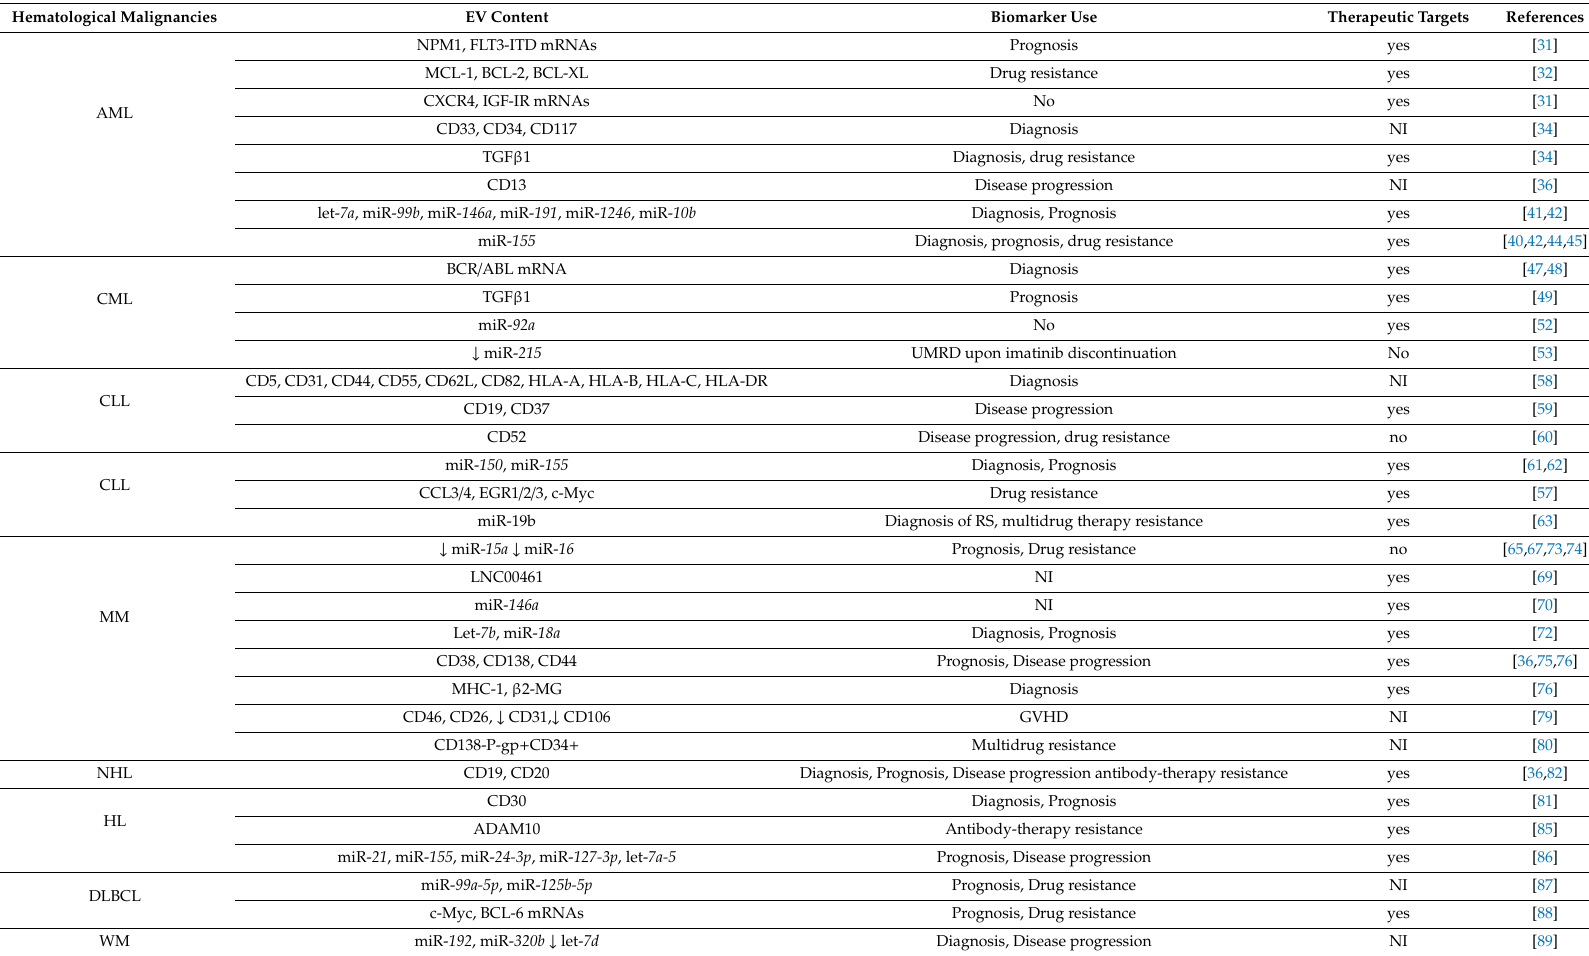
Table 1. Overview of the hematological malignancy-derived EVs as potential biomarkers of disease and therapeutic targets on the basis of their content. Hematological